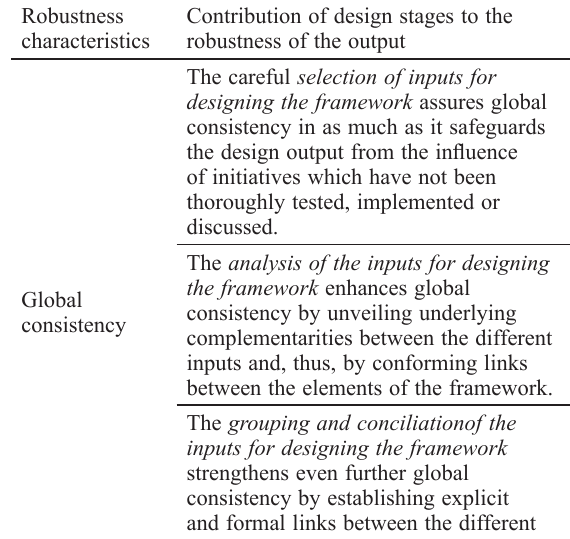
Table 5. Verification of the robustness of the proposed RM- PBB framework Robustness characteristics